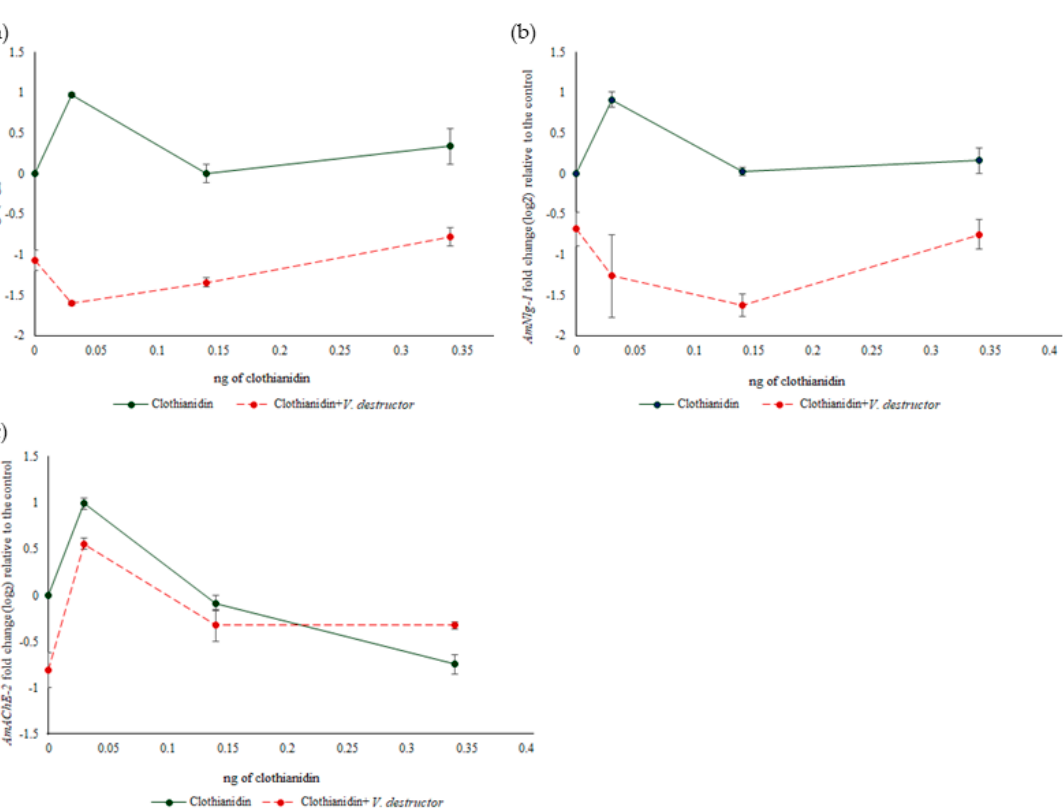
Figure 4. Mean ( ± SEM) relative expression versus ng of clothianidin of bees positive to PER of the genes: AmNrx-1 ( a ); AmNlg-1 ( b ); AmAChE-2 ( c ). The relative gene expression was calculated using the Livak 2 − ∆∆ Ct method, with AmRPS5 as reference gene and 0 ng as calibrator. Log 2 transformed data are presented.